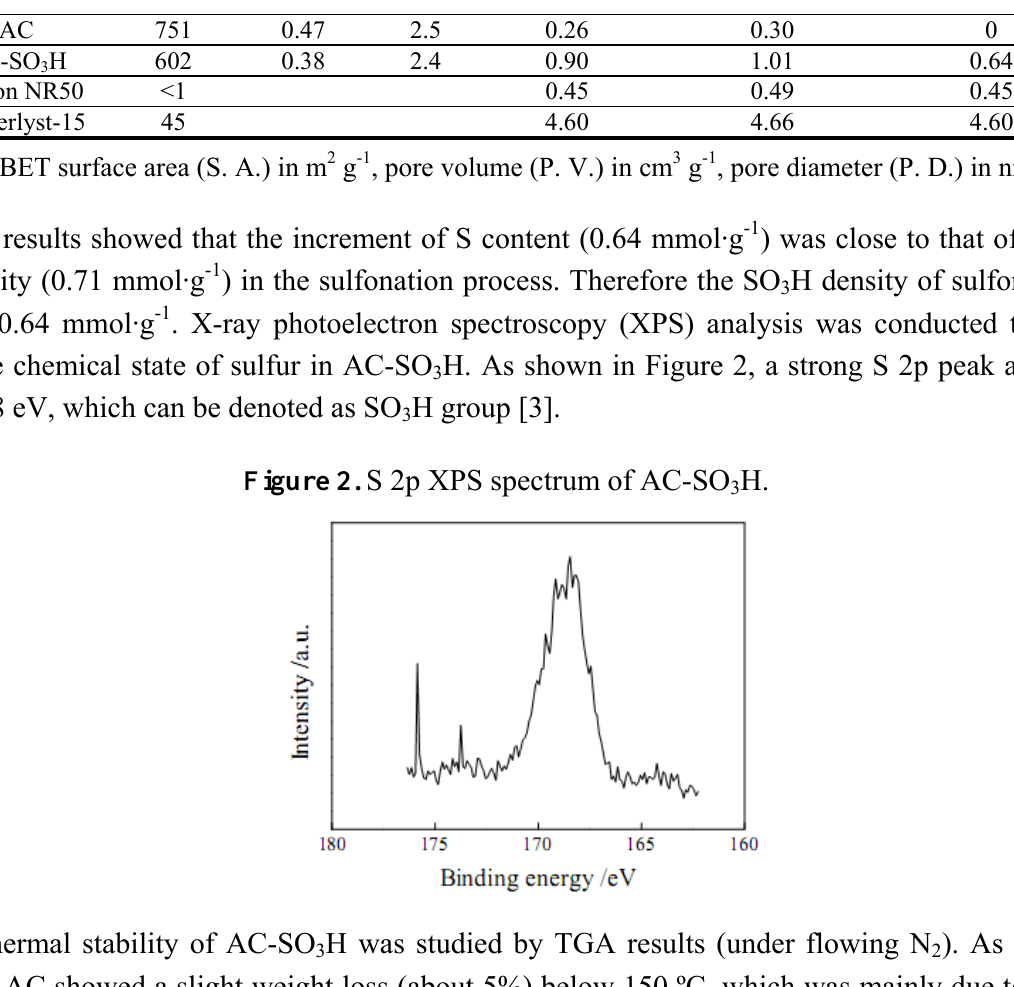
Table 1. The textural properties of the materials.